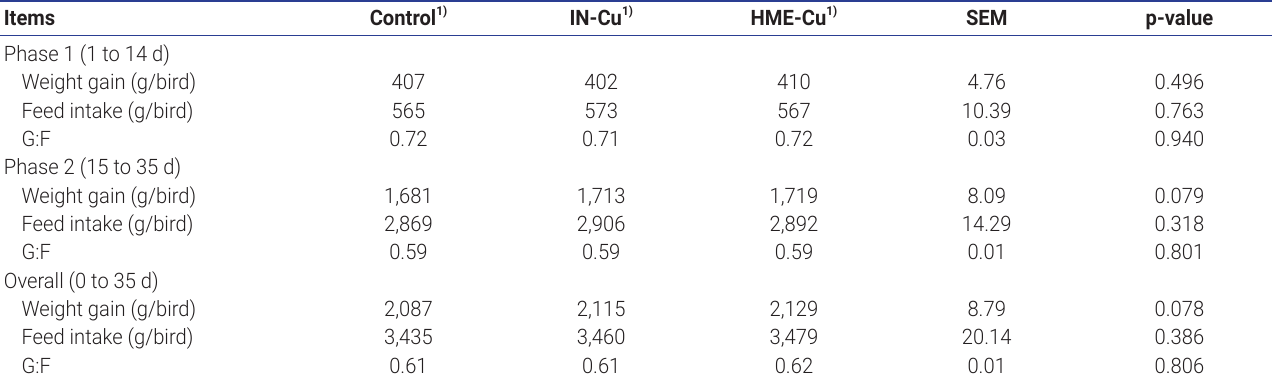
Table 3. Effect of dietary Cu concentrations and sources on growth performance in broilers